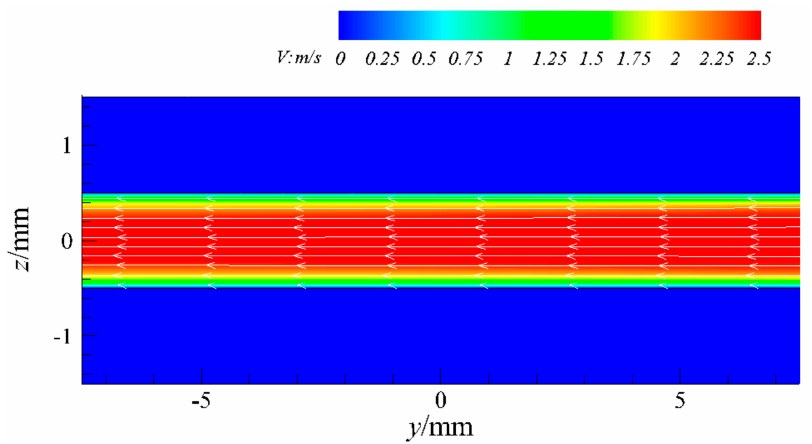
Figure 10. Velocity distribution of channel’s center section ( x = 28.5 mm).